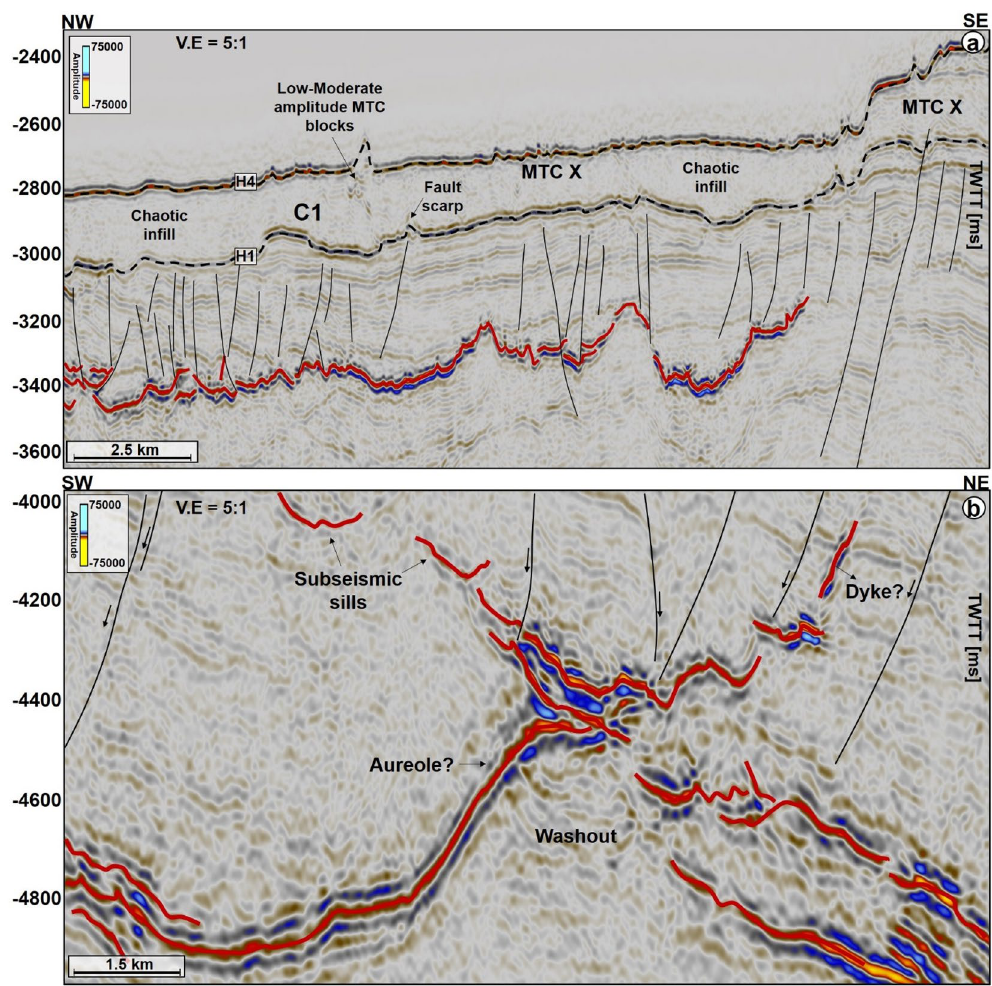
Figure 10. ( a ) NW–SE arbitary line showing several interconnected sills under C1 in the SMA area. ( b ) Zoomed-in image of the deeper sill complex in Fig. 9a. Deeper in the succession, some of the sills include low-moderate amplitude reflections, which are interpreted as thin magmatic sills below minimum seismic resolution. The amplitude washout zones around the sills are also interpreted as contact aureoles between the sills and their host strata. N.B: Uninterpreted seismic profiles are provided in the